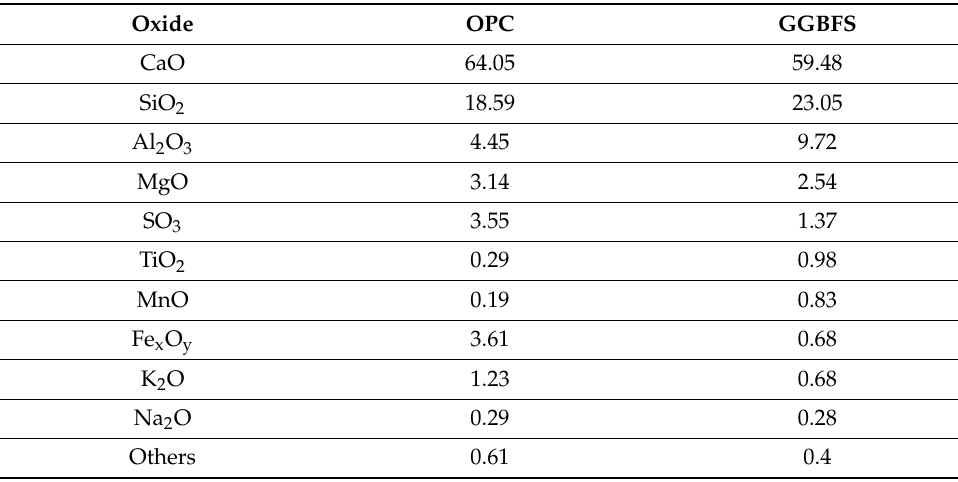
Figure 1. Particle size distributions of OPC and GGBFS. Table 1. Oxide compositions: OPC and GGBFS (wt%).